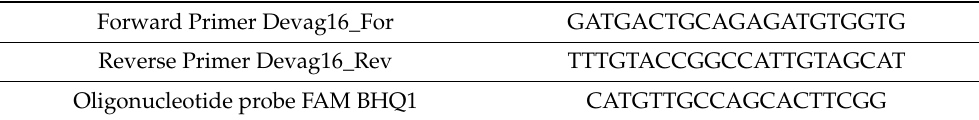
Table 3. Primers and probe used in the PCR for detection of Devriesea agamarum . Forward Primer